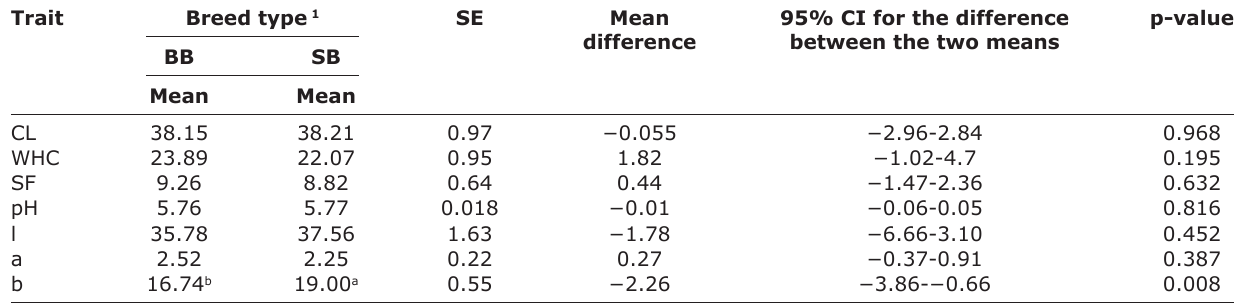
Table-4: Means, SE, and 95% CI for the difference between the means for meat quality traits of BB and SB kids. Trait